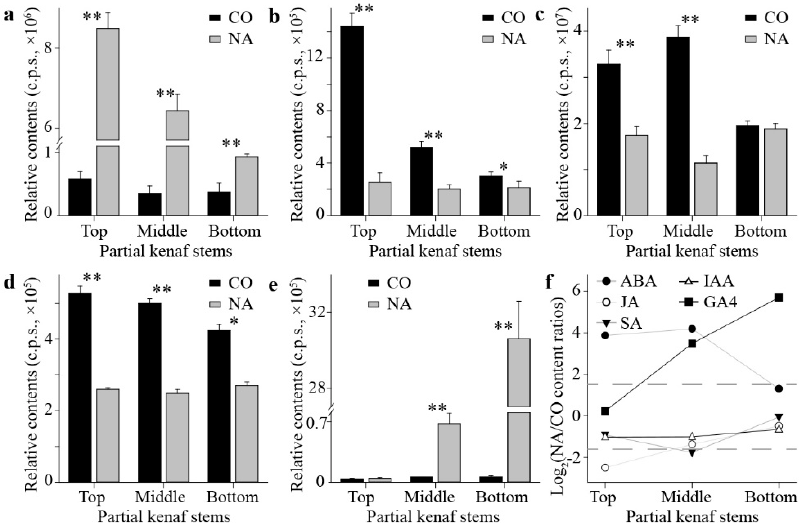
Figure 7. Relative contents of various phytohormones in the three kenaf stem parts at control (CO) and salt stress (NA) conditions. The relative contents of ABA ( a ), JA ( b ), SA ( c ), IAA ( d ), and GA4 ( e ) were respectively displayed. Meanwhile, the NA-to-CO contents ratio of these phytohormones was also presented ( f ). The * or ** indicate the significant difference at threshold of 0.05 or 0.01 under Student’s t-test, respectively.